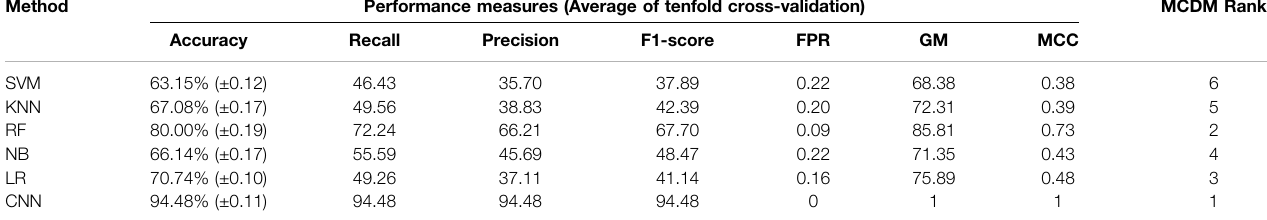
TABLE 6 | Models performance and ranking for external data